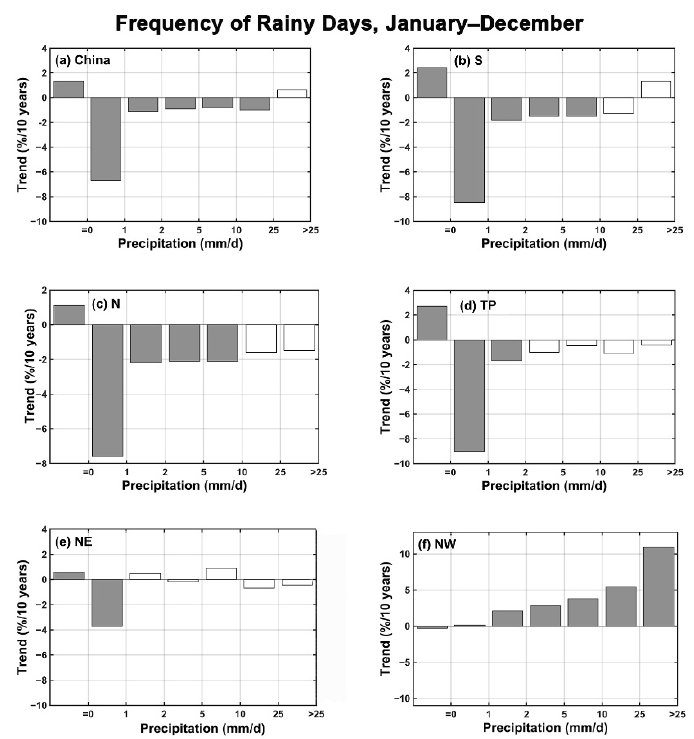
Figure 8. The decadal trend of relative changes of precipitation occurrence frequency for different types of precipitation over ( a ) the whole China region, along with the five classified regions of ( b ) South China (S), ( c ) North China (N), ( d ) Tibetan Plateau (TP), ( e ) Northeast China (NE), and ( f ) Northwest China (NW).